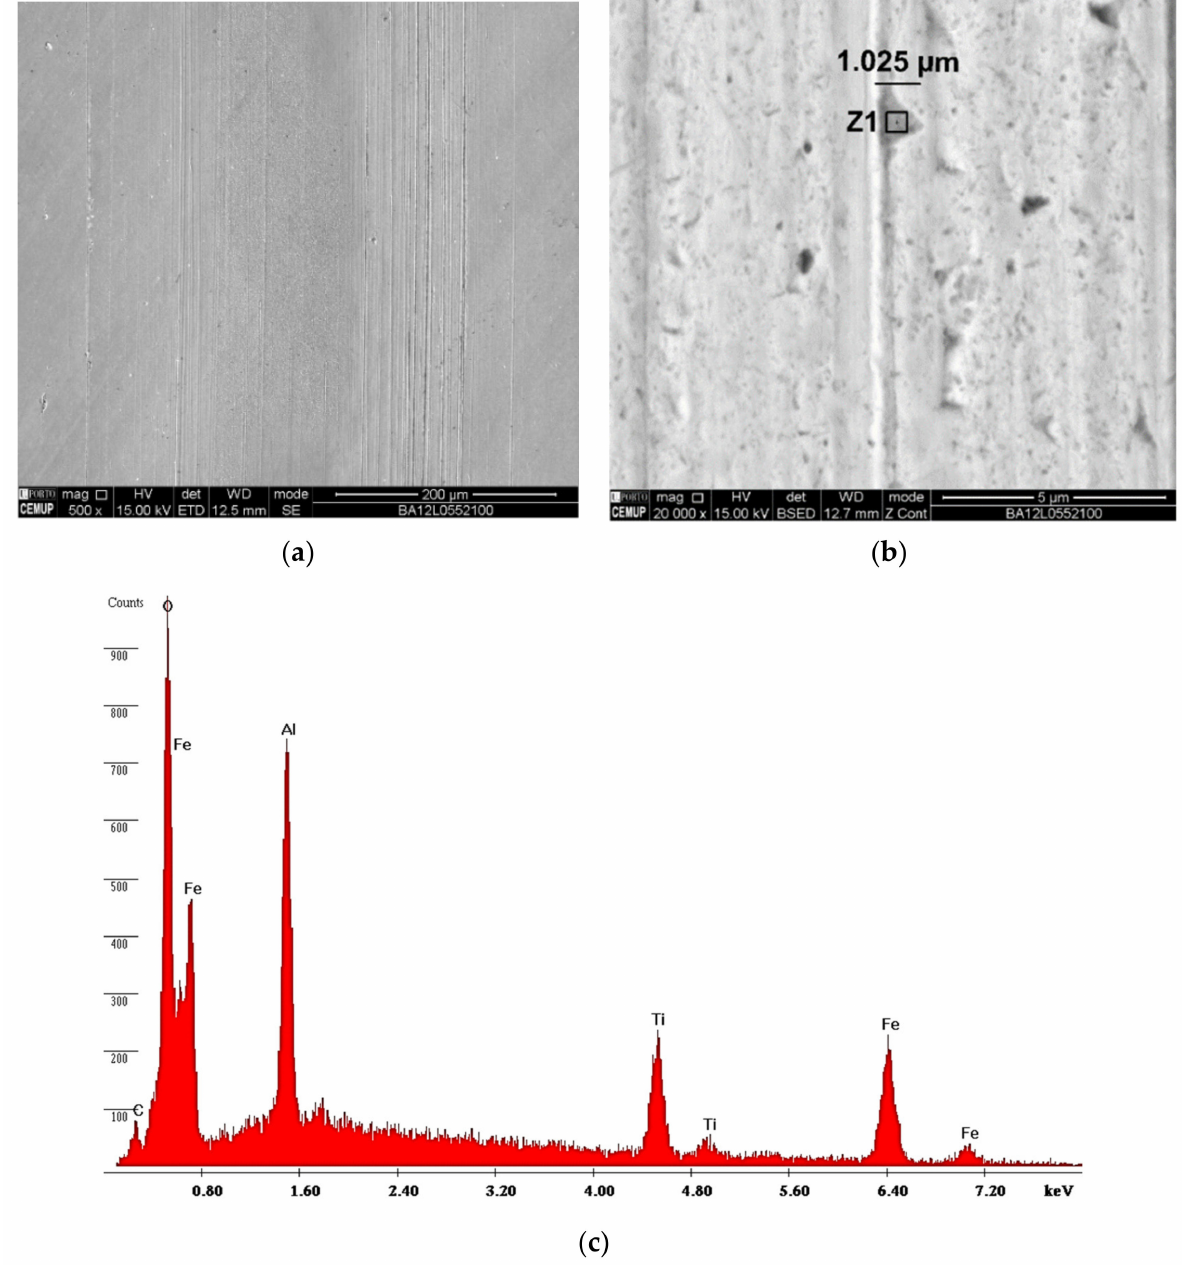
Figure 17. SEM track analysis for abrasive alumina powder (1 µ m) with 0.5 N load for AISI 52100 ball: ( a ) track on the ball, ( b ) embedded alumina particle, ( c ) EDS spectrum in the Z1 zone indicating alumina